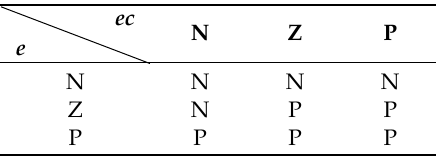
Table 1. Fuzzy rules of k P .